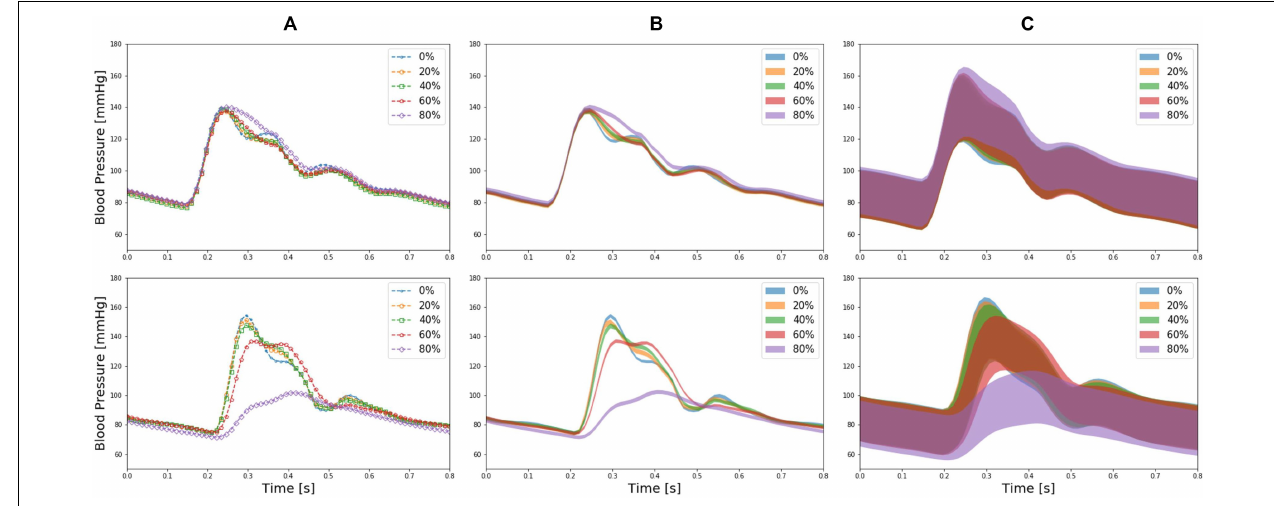
FIGURE 4 | Brachial (upper panel) and ankle (lower panel) blood pressure (BP) waveforms corresponding to (A) nominal virtual patient (i.e., virtual patient with nominal anatomical and physiological parameter values), (B) nominal virtual patient with intra-individual variability, and (C) all the virtual patients with inter- and intra-individual variability in the test dataset, all associated with varying PAD severity levels.